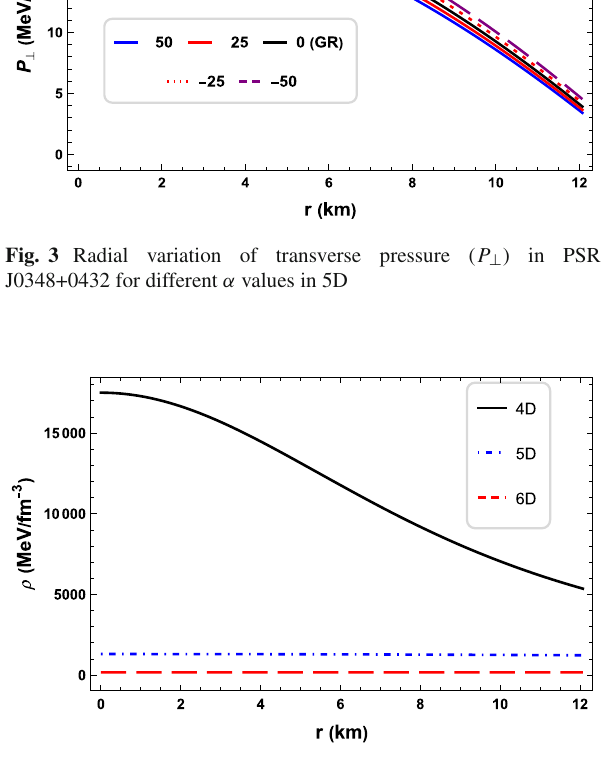
Fig. 4 Comparison of radial variation of energy-density ( ρ ) in PSR J0348+0432 for α = 25 in 4D, 5D and 6D